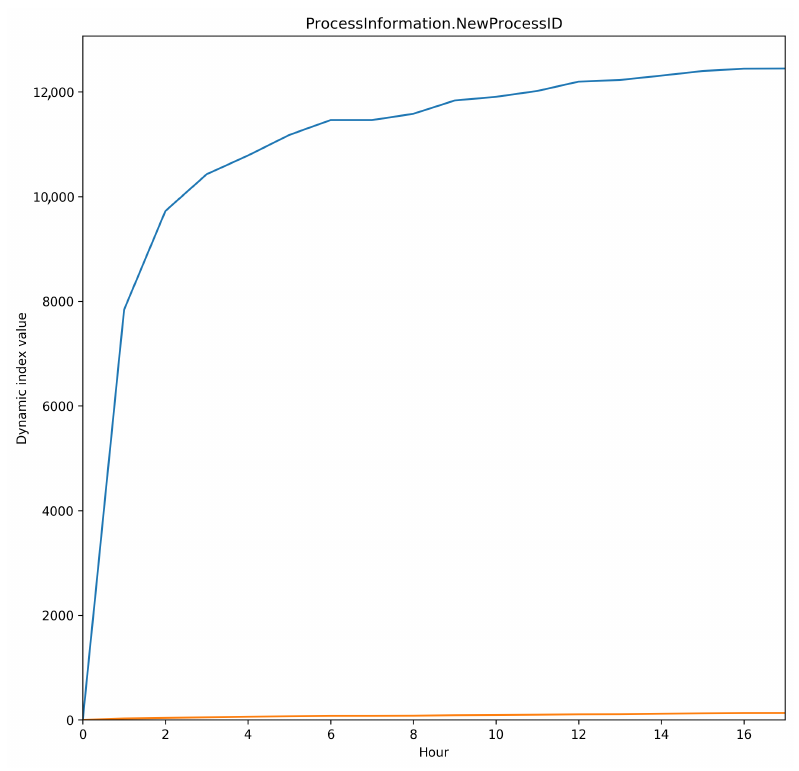
Figure 10. Dynamic indexes for the ProcessInformation.NewProcessID event